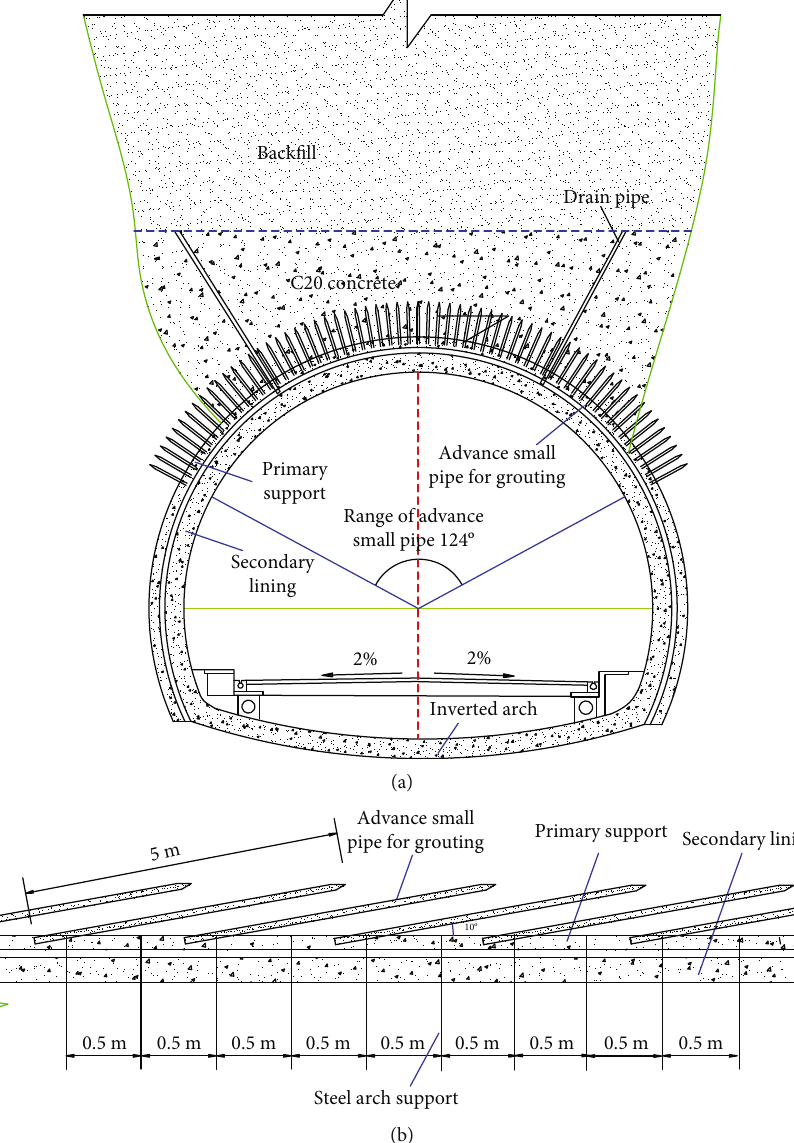
Figure 10: Diagram of collapse and mud inrush treatment: (a) cross-section diagram of disaster treatment; (b) longitudinal section diagram of advance small pipe